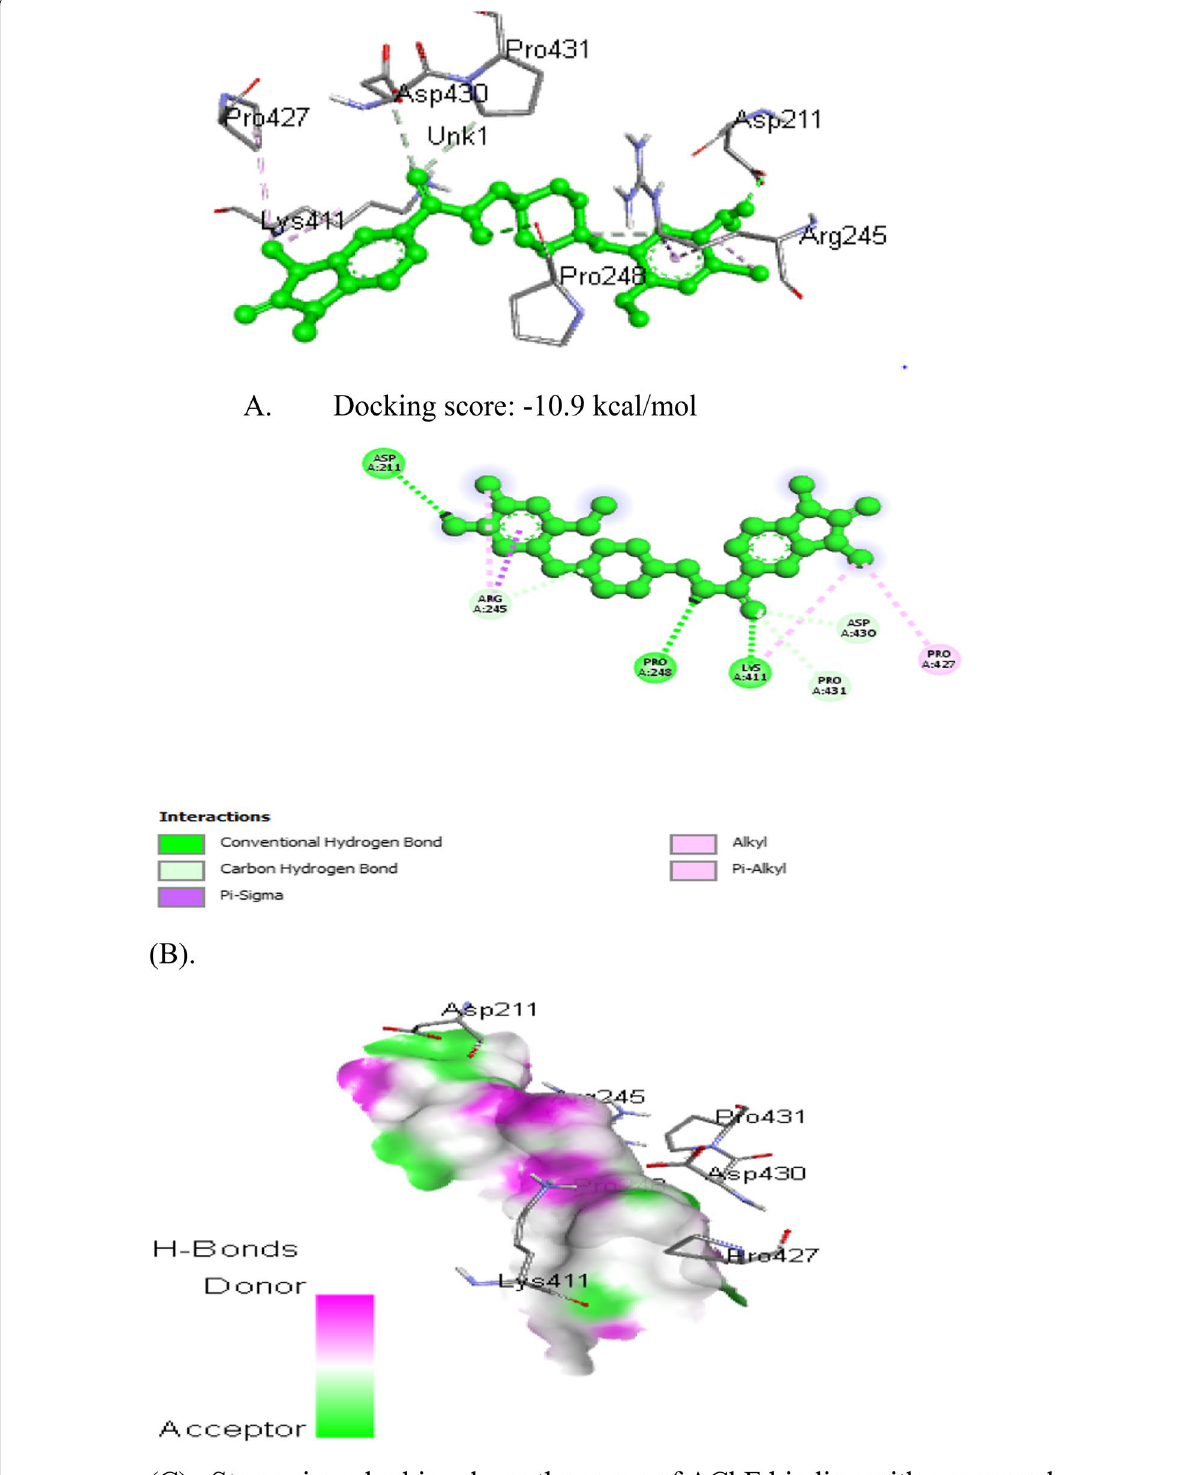
Fig. 6 A and B showed the 3D and 2D docking interactions between ligand 21 and receptor,